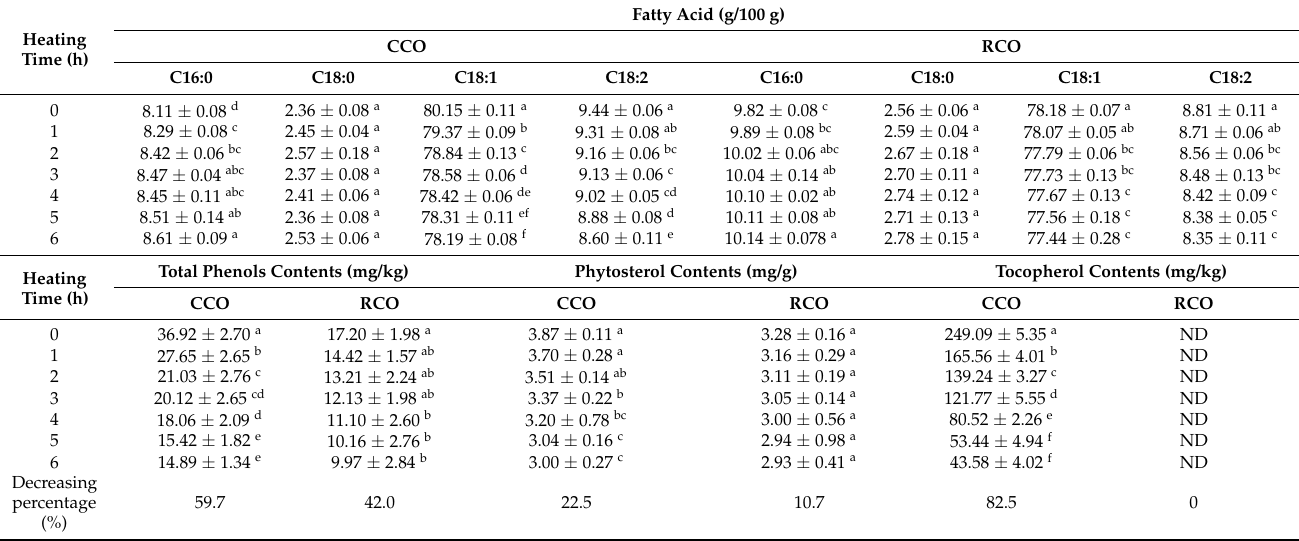
Table 1. Fatty acid composition and lipid companion contents of crude C. Oleifera oil and refined C. Oleifera oil during